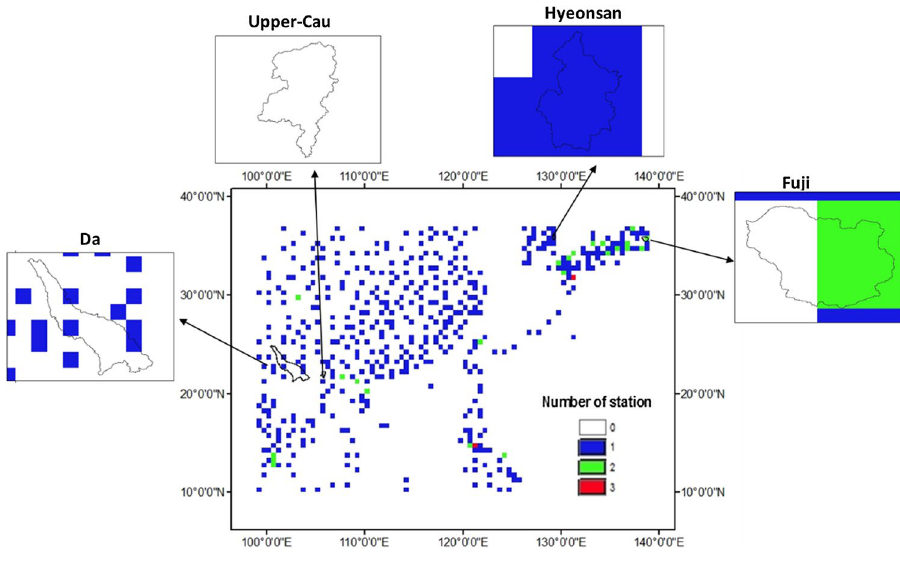
Fig. 6 Relationship between local rain gauge data and CPC global gauge data set in a Da, b Upper-Cau, c Hyeonsan, d